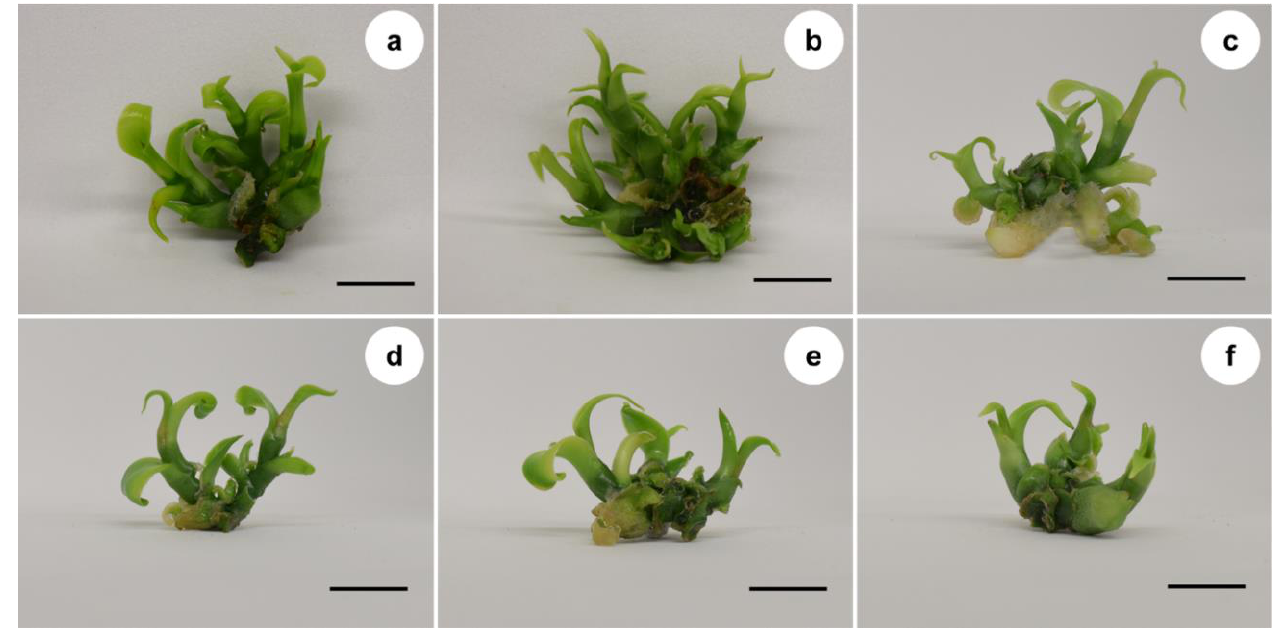
Figure 2. Effect of different doses of gamma irradiation on in vitro shoot development of vanilla ( Vanilla planifolia Jacks. ex Andrews) at 60 days of culture; ( a – f ) 0, 20, 40, 60, 80 and 100 Gy, respectively. Black bar = 1 cm.